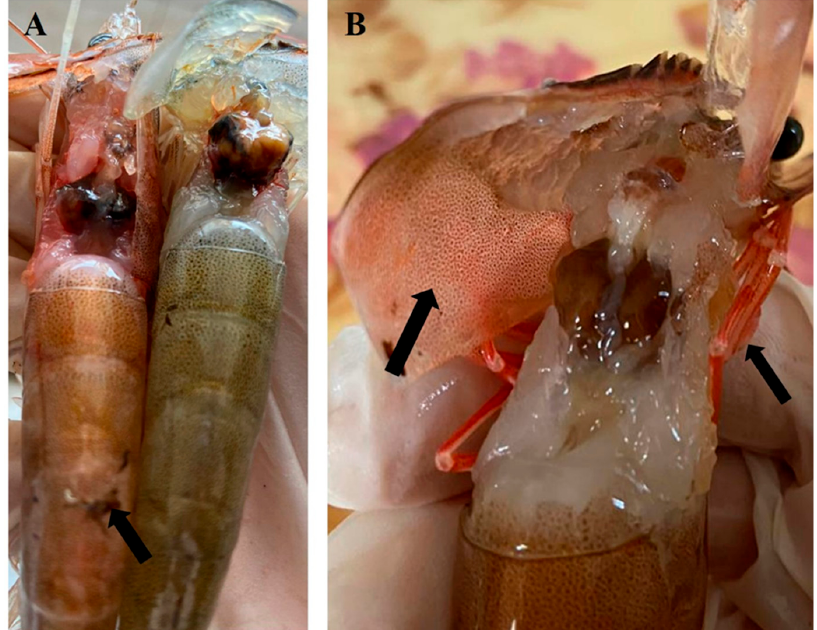
Figure 2. ( A ): Hatchery field cases of infected and normal broodstock shrimp, Litopenaeus vannamei . ( B ): infected shrimp show reddish discoloration of abdominal muscles, hepatopancreas, and pleopods, with a melanized area on the reddish abdominal cuticle (arrow). Red-colored spots are shown on the carapace with pereopods (arrow).